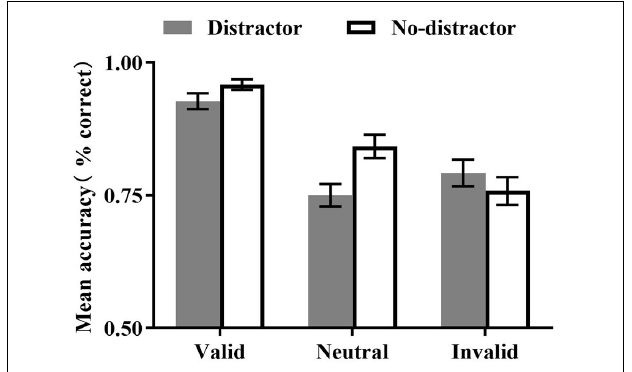
FIGURE 2 | Mean accuracy ( ± SE) as a function of cue type and